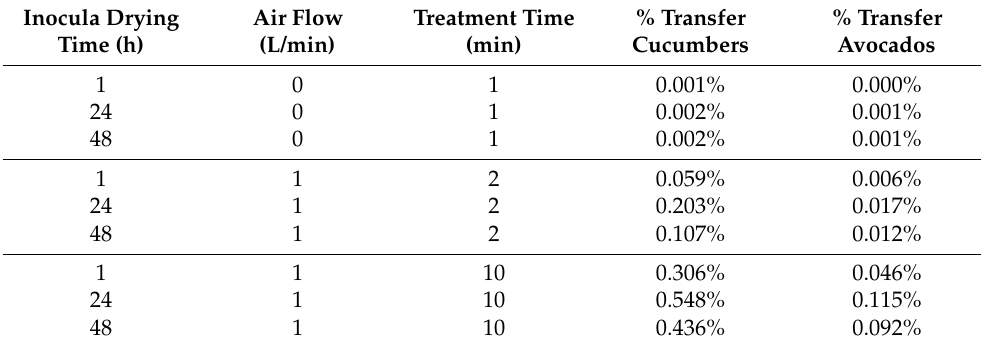
Table 1. Listeria monocytogenes transfer from inoculated, dried and rinsed cucumbers or avocados to uninoculated fruit ( n = 3).